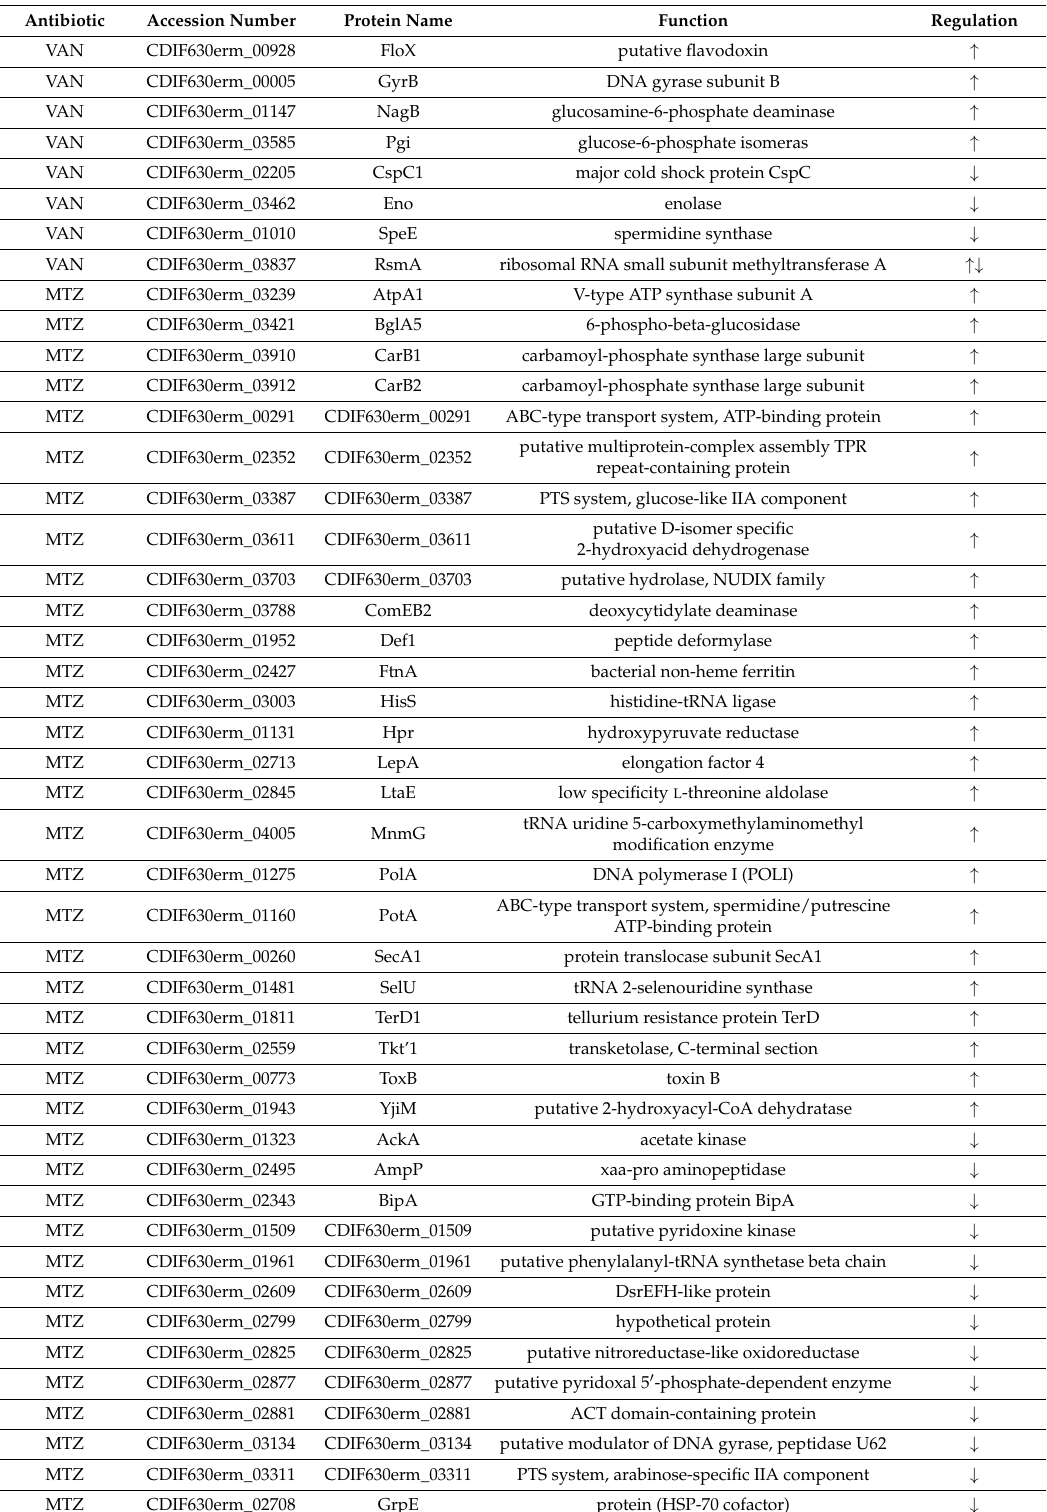
Table 2. This table lists all proteins uniquely regulated after treatment with the antibiotic they were assigned to (vancomycin (VAN), metronidazole (MTZ), fidaxomicin (FDX)). Column “regulation” indicates up ( ↑ ) or downregulation ( ↓ ) in both sampling points (10 and 30 min) or changing regulation during adaptation ( ↑↓